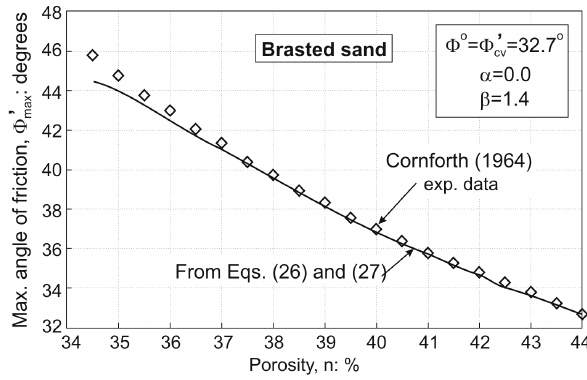
Fig. 6. Maximum friction angle of Brasted sand